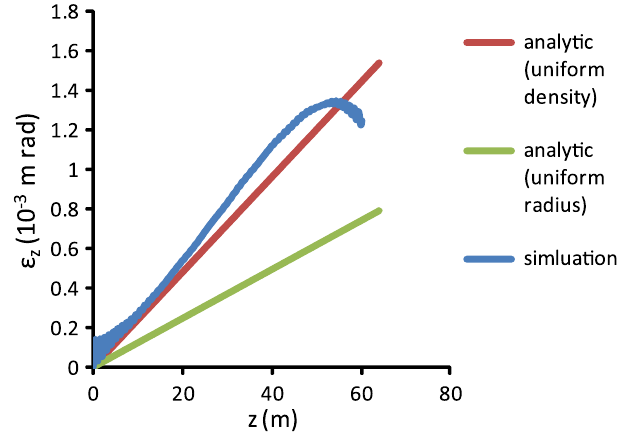
FIG. 20. z emittance vs z (m), showing 2 cases with uniform beam radius (green), uniform charge density (red), and WARP simulation